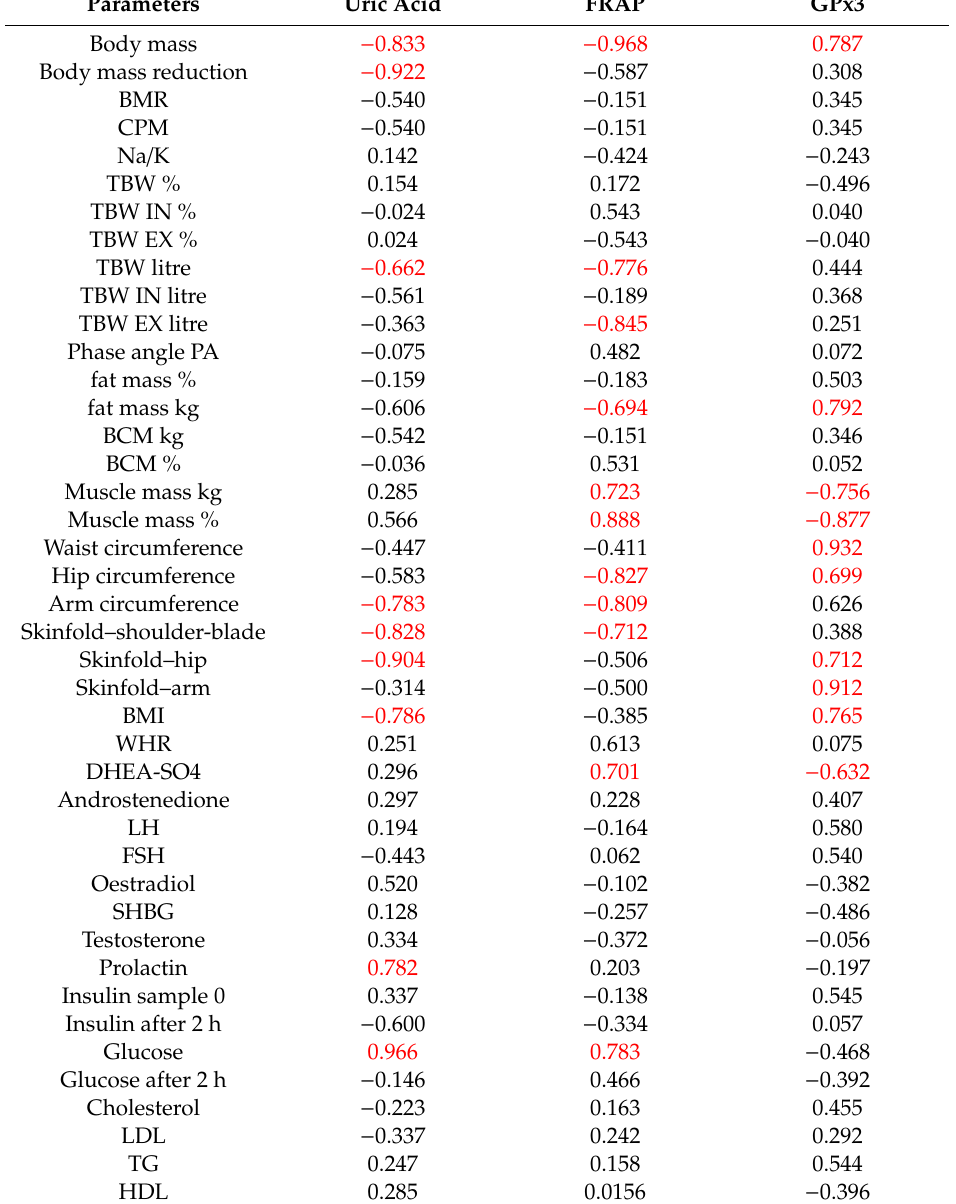
Table 3. Correlation matrix between anthropometric and biochemical parameters and antioxidants (uric acid, FRAP, GPx3) in women with PCOS after dietary